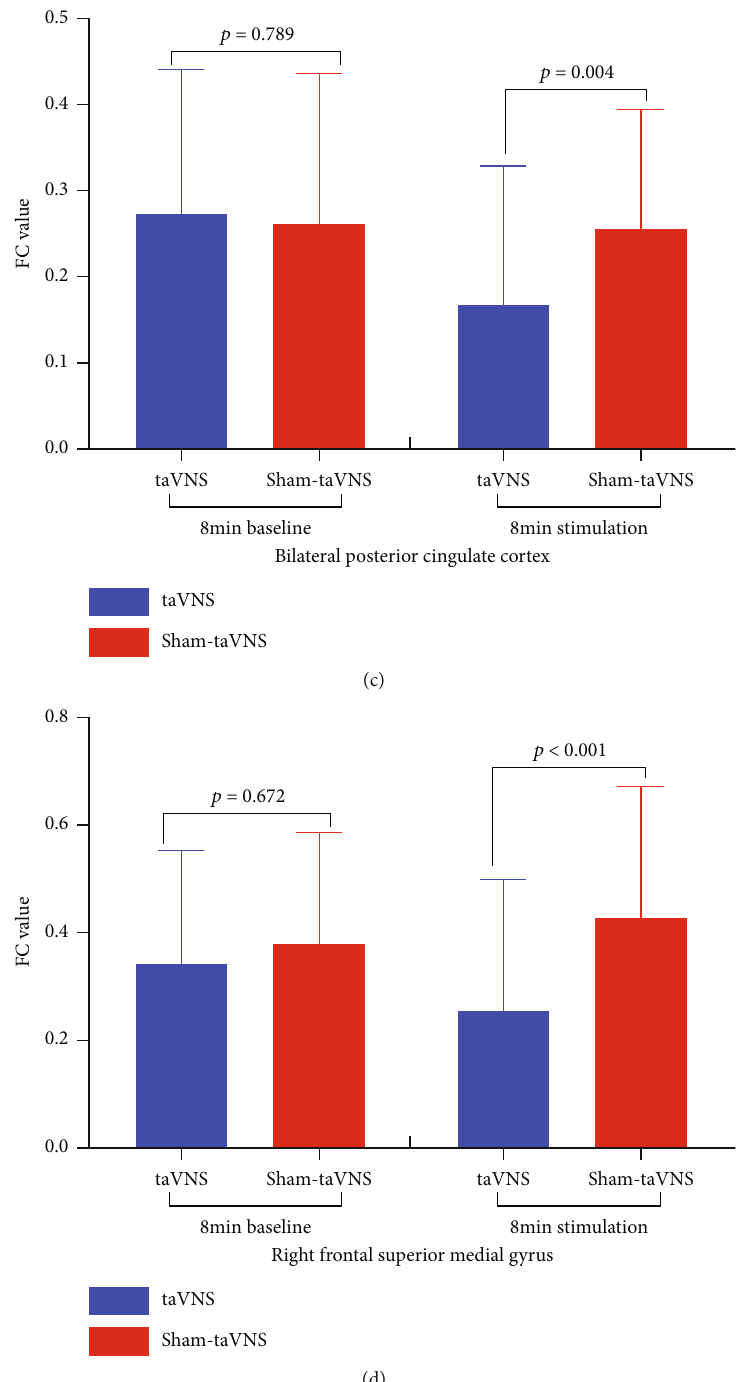
Figure 4: The e ff ects on the functional connectivity (FC) of the left amygdala between stimulations and time factors. SMA: supplementary motor area. A paired t -test was used. If p < 0 : 05 , the di ff erence was statistically signi fi cant. Before stimulation, there was no statistical signi fi cance for the FC of (a) the left amygdala and left MFG and SFG, (b) right SMA and paracentral lobule, (c) posterior cingulate cortex, (d) and frontal superior medial gyrus (taVNS versus staVNS). During stimulation, their di ff erences were signi fi cant. The intensity of the FC decreased in taVNS and increased in staVNS (prestimulation vs. during stimulation). Therefore, the trend of the changed FC was opposite between taVNS and